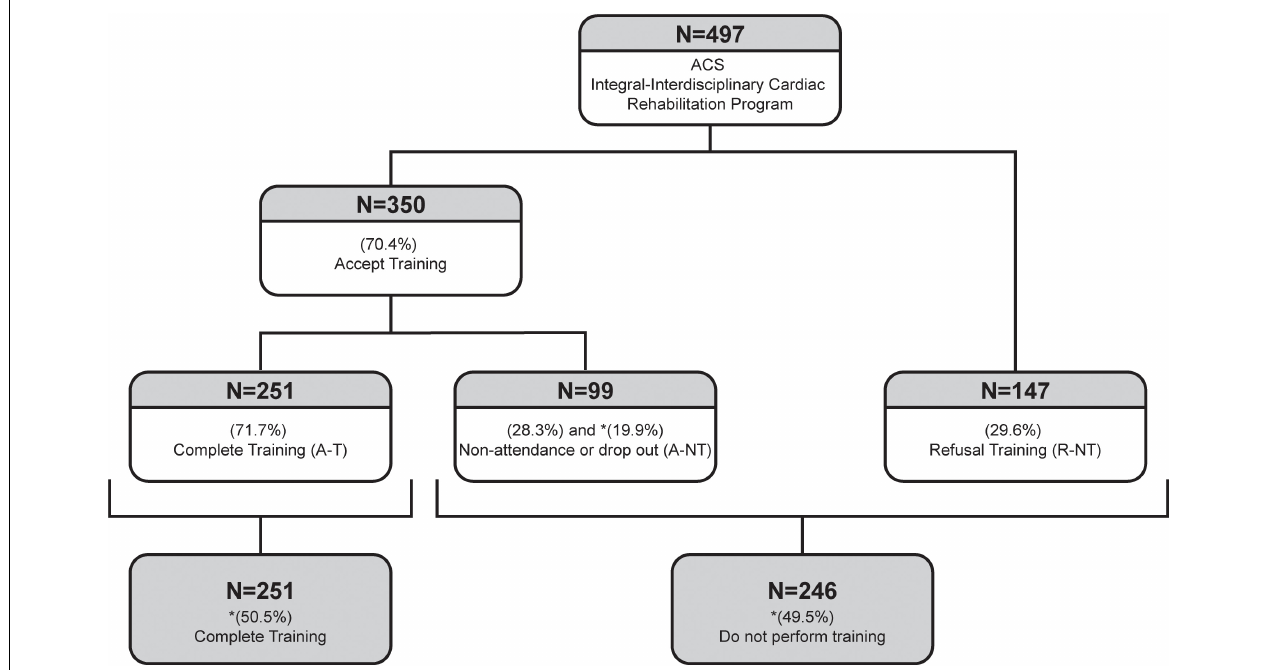
FIGURE 1 | Flow chart of patients in the cardiac rehabilitation program. ACS, Acute coronary syndrome; R-NT, Rejected and did not perform training; A-T, Accepted and did exercise training; A-NT Accepted but did not do/complete training; CV, Cardiovascular. Data are expressed in percentages to the preceding category. Data with an asterisk (*) were calculated to refer to the whole